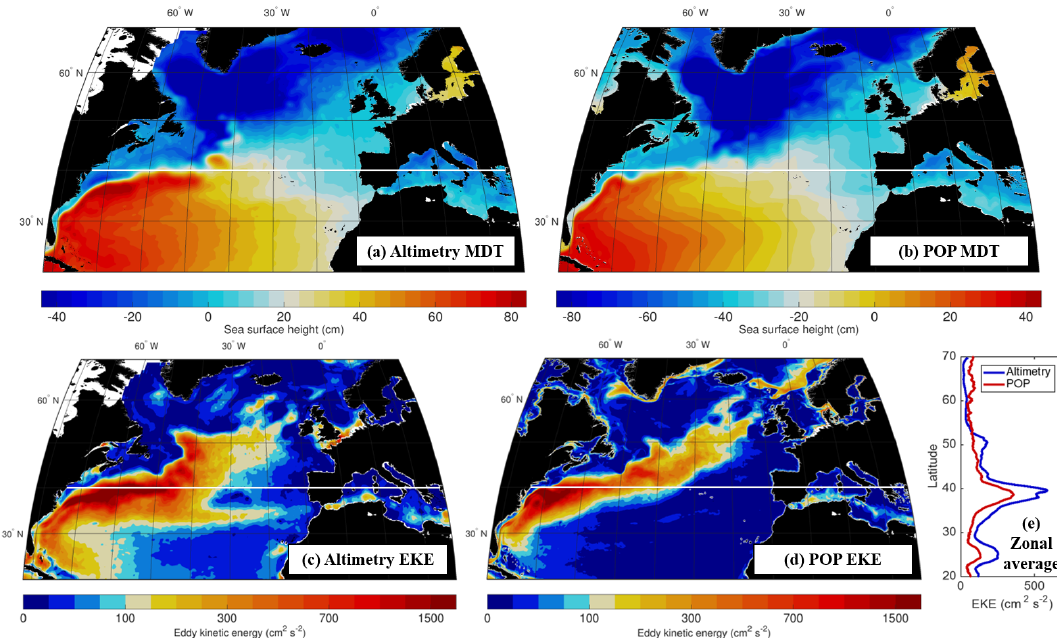
Figure 1. Comparison of mean dynamic topography from (a) CMEMS altimetry (1993–2016) and (b) the POP simulation (1978–2009). The white line indicates the 40 ◦ N latitude transect, the focus of this study. Comparison of surface eddy kinetic energy (EKE) from (c) altimetry and (d) POP with the sea surface height low-pass filtered to remove variability at scales smaller than 0.5 ◦ , the Nyquist wavelength of the altimetry product. (e) Comparison of Atlantic zonally averaged surface EKE from altimetry and POP.